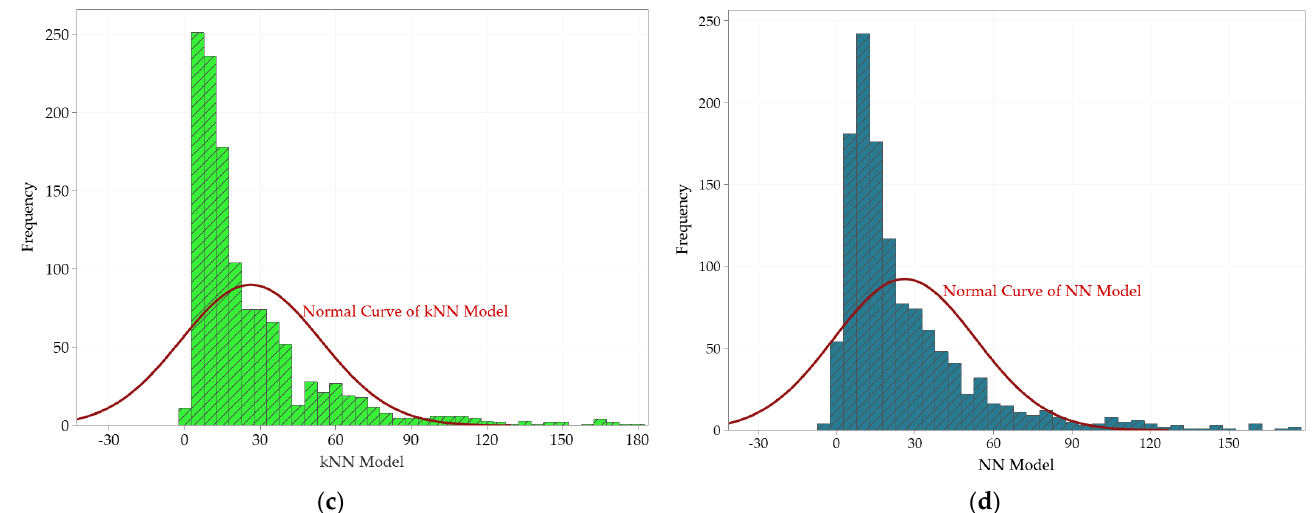
Figure 6. The comparison between actual and forecast data for the delivery time variable: ( a ) actual value vs. RF algorithm; ( b ) actual value vs. GB algorithm; ( c ) actual value vs. k NN algorithm; ( d ) actual value vs. NN algorithm.